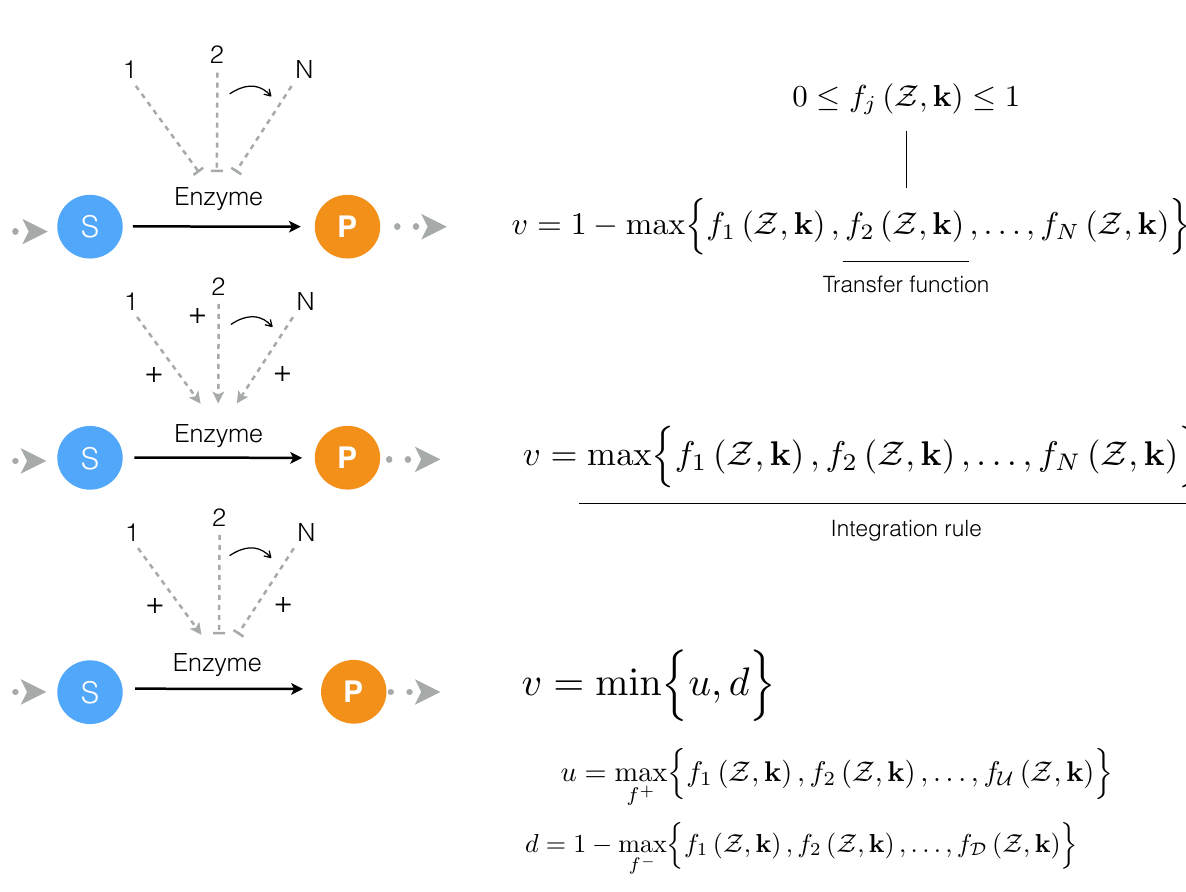
v 1 . Control variables are functions j ≤ ≤